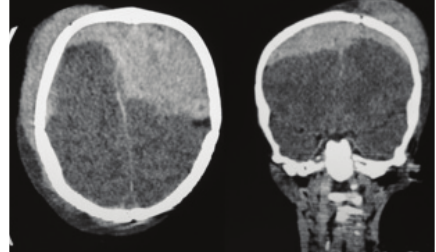
Figure 1: Axial and coronal CT scan images showing vertex epidu- ral haematoma in preoperative course.